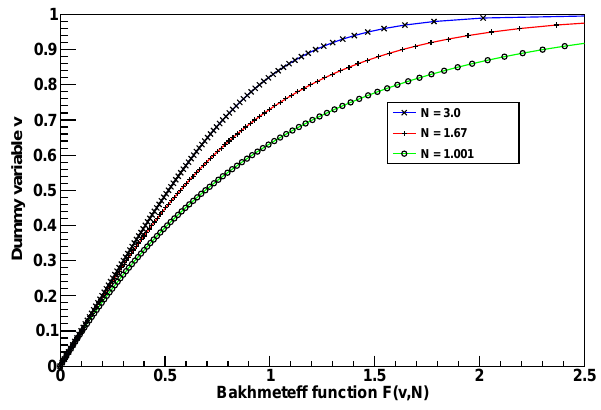
Fig. 3. The Bakhmeteff varied-flow function for three different de- grees of watershed nonlinearity, N . N =1.001 for nearly linear, 1.67 for moderately nonlinear, and 3.0 for highly nonlinear